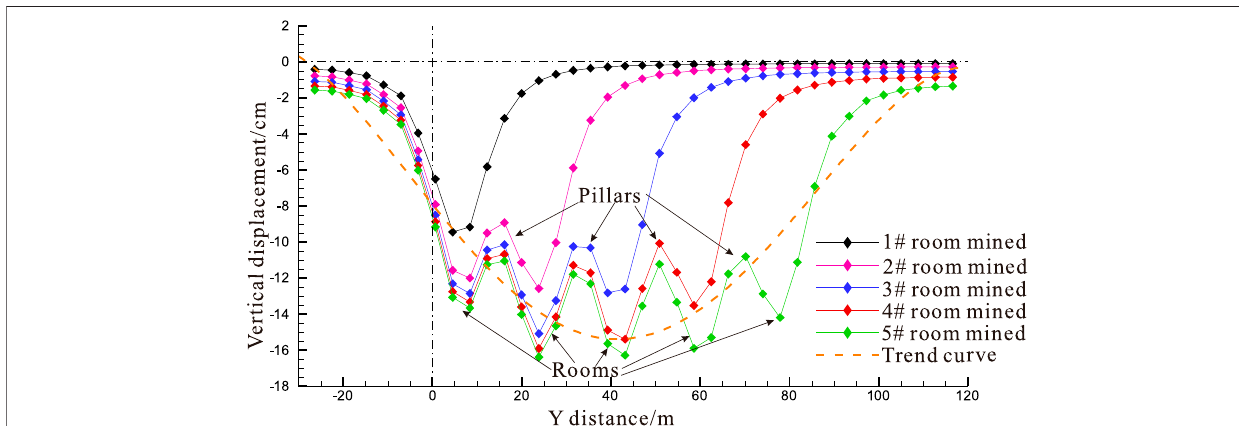
FIGURE 6 | Vertical displacement curves of the roof during stoping the rooms 1# to 5#.